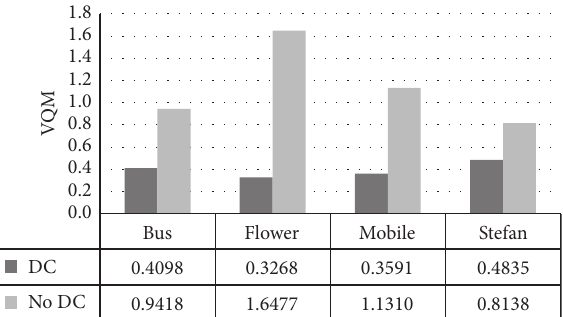
Figure 14: VQM comparison between schemes with DC and without